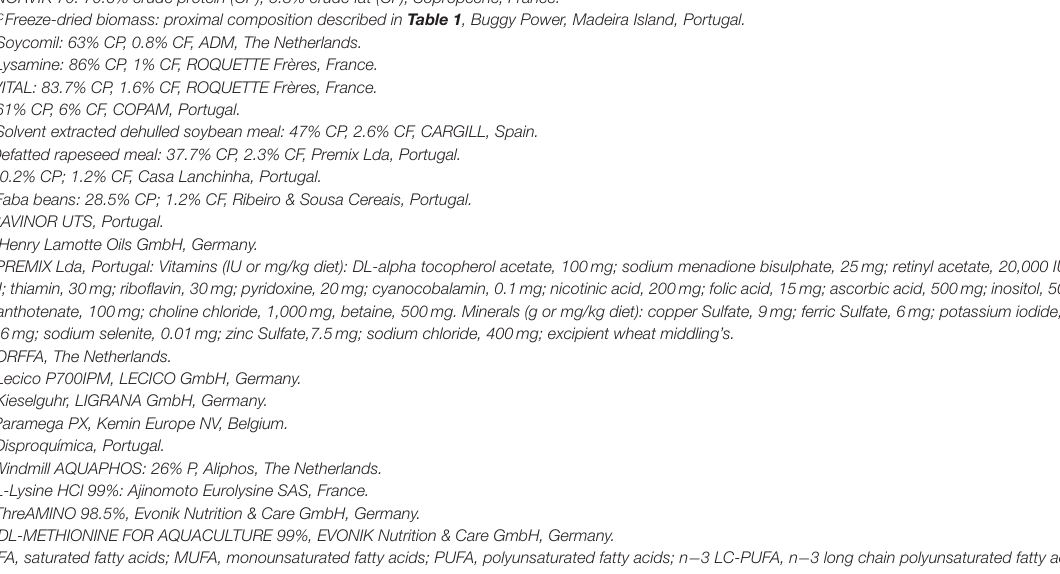
TABLE 2 | Ingredient composition and proximate analysis of the experimental diets. Ingredients (%) Fishmeal